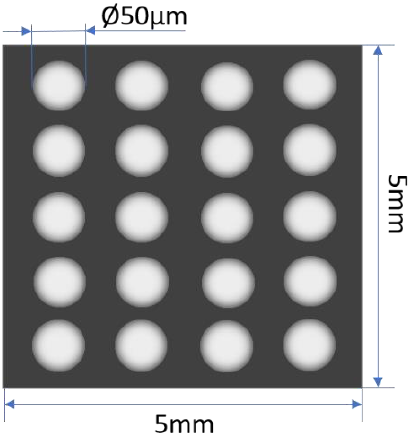
Figure 2. Schematic diagram of stainless steel sheet with pore array.